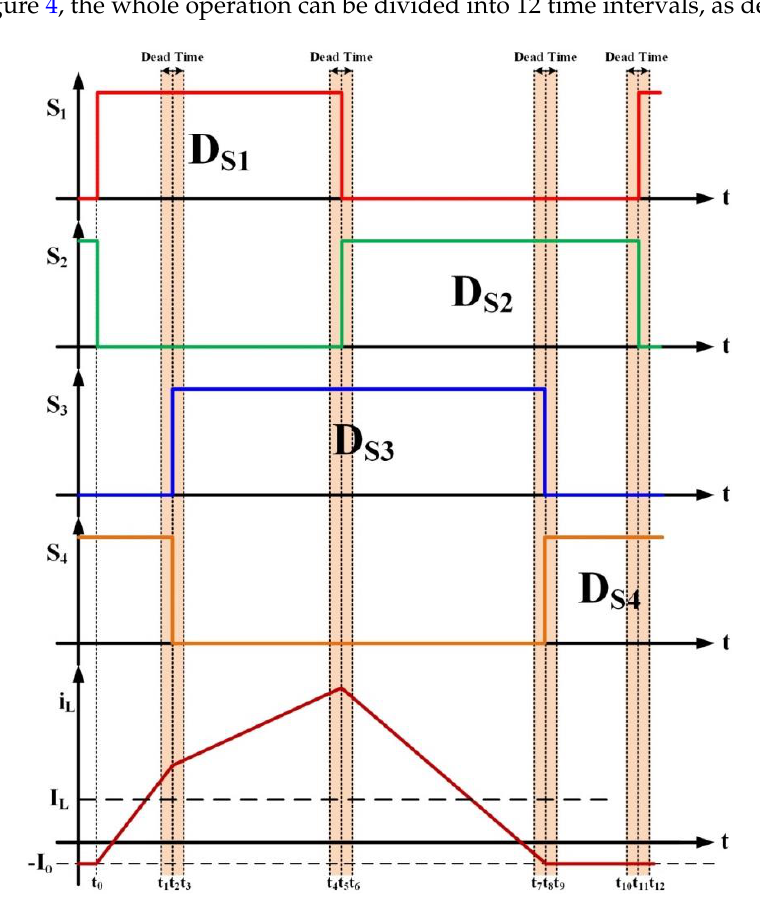
Figure 4. Typical waveforms of buck-charging mode.